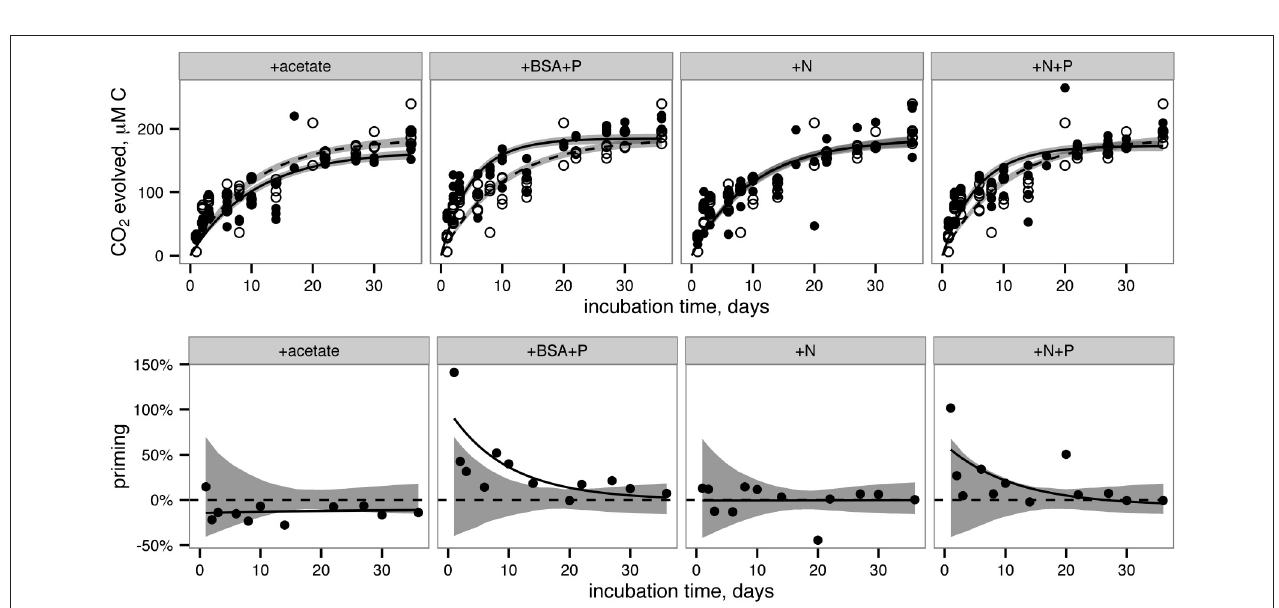
FIGURE 3 | CO 2 production (top row) and priming (bottom row) in each treatment. Top row: Filled circles and solid indicate data from treatments. Open circles and dashed lines indicate data from the control (i.e., no added compounds) and are repeated in each panel for reference. Lines indicate best fits to Equation 3 (provided in Methods). Shaded bands indicate standard error of the model fits estimated by a Monte Carlo technique. Bottom row: Priming, calculated according to Equation 4 (provided in Methods). Circles indicate priming calculated from the average CO2 concentrations at each timepoint. Solid lines represent priming calculated from the fit lines shown in the top panel for each corresponding treatment. Shaded bands indicate the region that is indistinguishable from zero